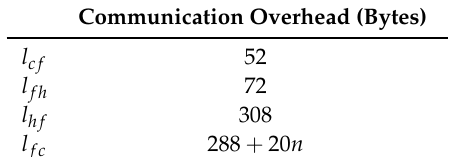
Table 2. The communication overhead of PDAF.